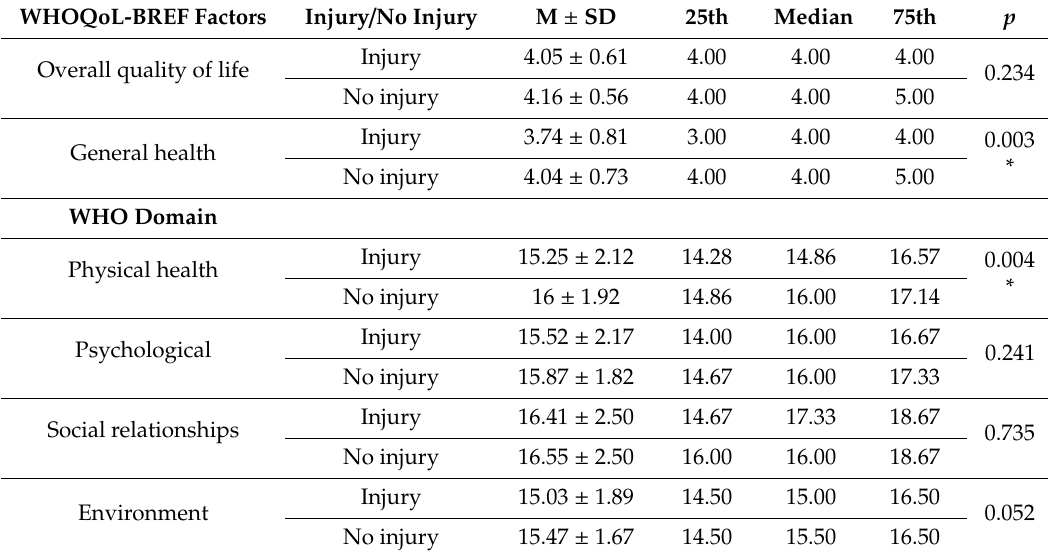
* Statistically significant for p < 0.05.